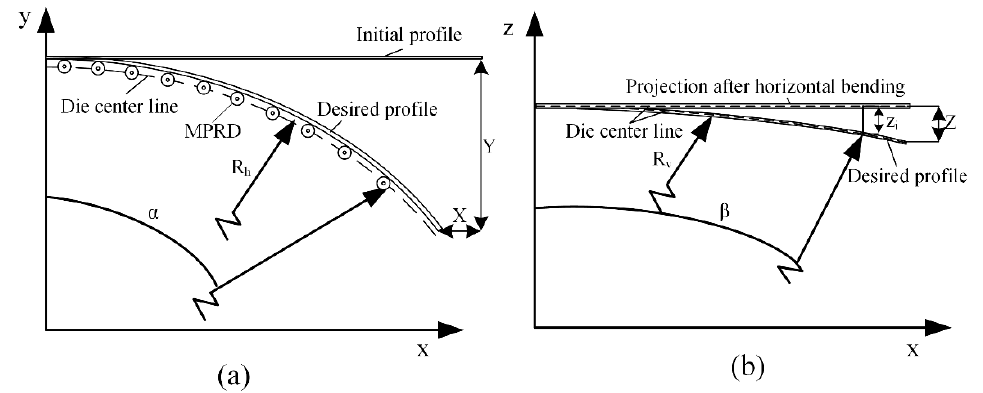
Figure 3. Trajectory design of clamp and MPRD. ( a ) Horizontal bending. ( b ) Vertical bending. The trajectory of the clamp is given by Equation